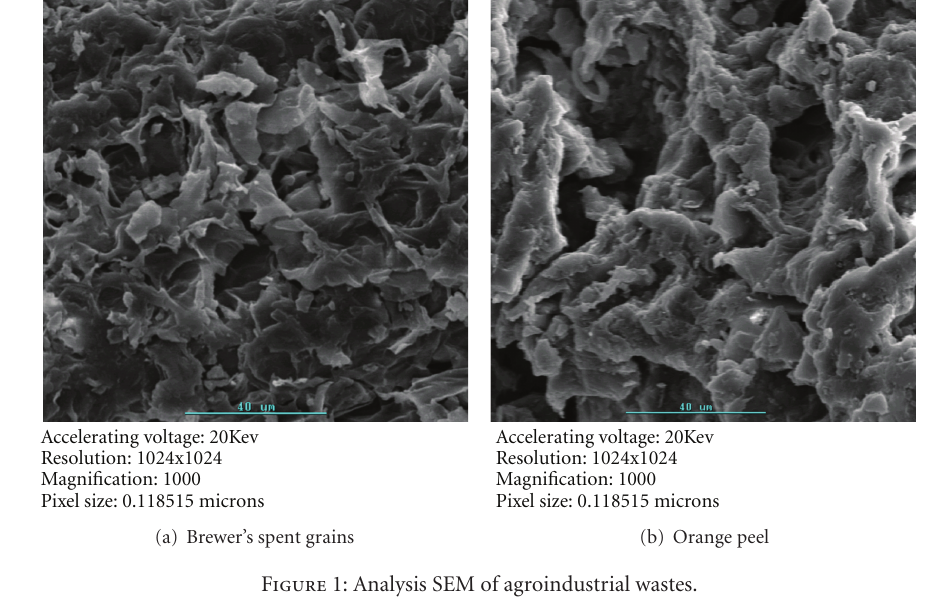
Figure 1: Analysis SEM of agroindustrial wastes.